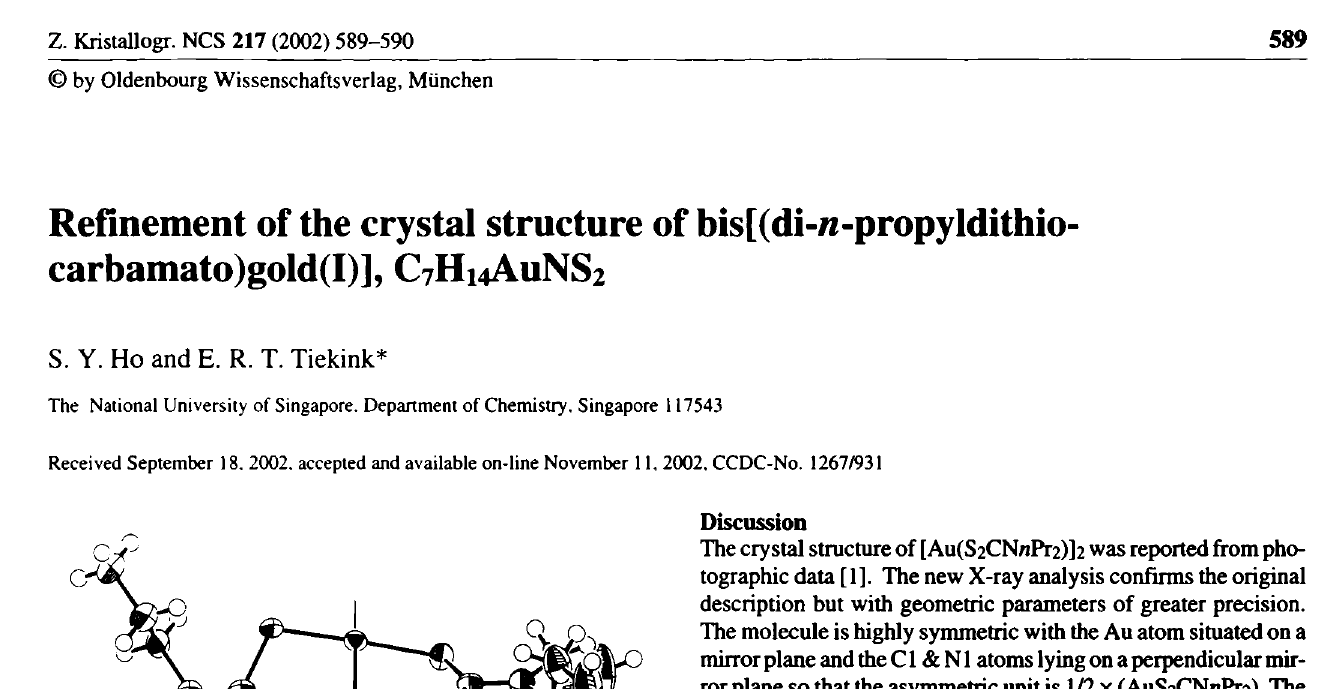
Table 1. Data collection and handling.